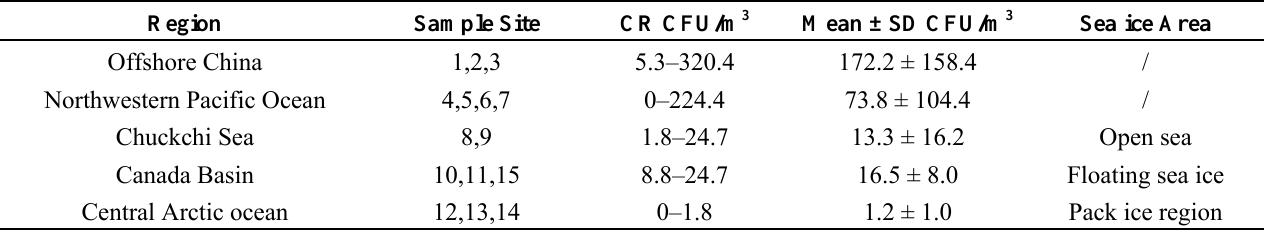
Table 2. Concentrations, sea ice and sample site of airborne fungi in different Sea